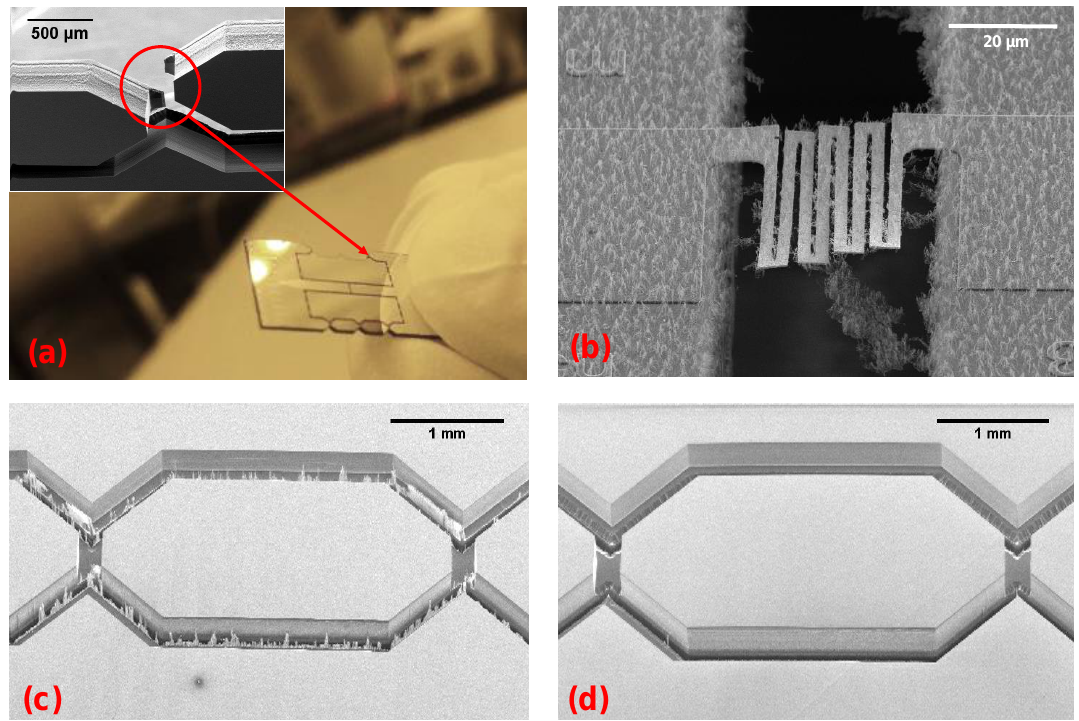
Figure 7. ( a ) A test device with a premature (directly after processing) breaking of the supporting beams at the v-notch points (see Figure 5) due to excessive thinning (fracture of the v-notch shown in inset); ( b ) Free standing interconnects after PI etch covered with residues; ( c ) SEM micrograph showing the back side of a test chip where remnants in the forms of spikes are visible, which are caused by the passivation that has been left over from the first step of the DRIE etch; ( d ) SEM micrograph of the same area of the device after an isotropic silicon etch shows the successful removal of the